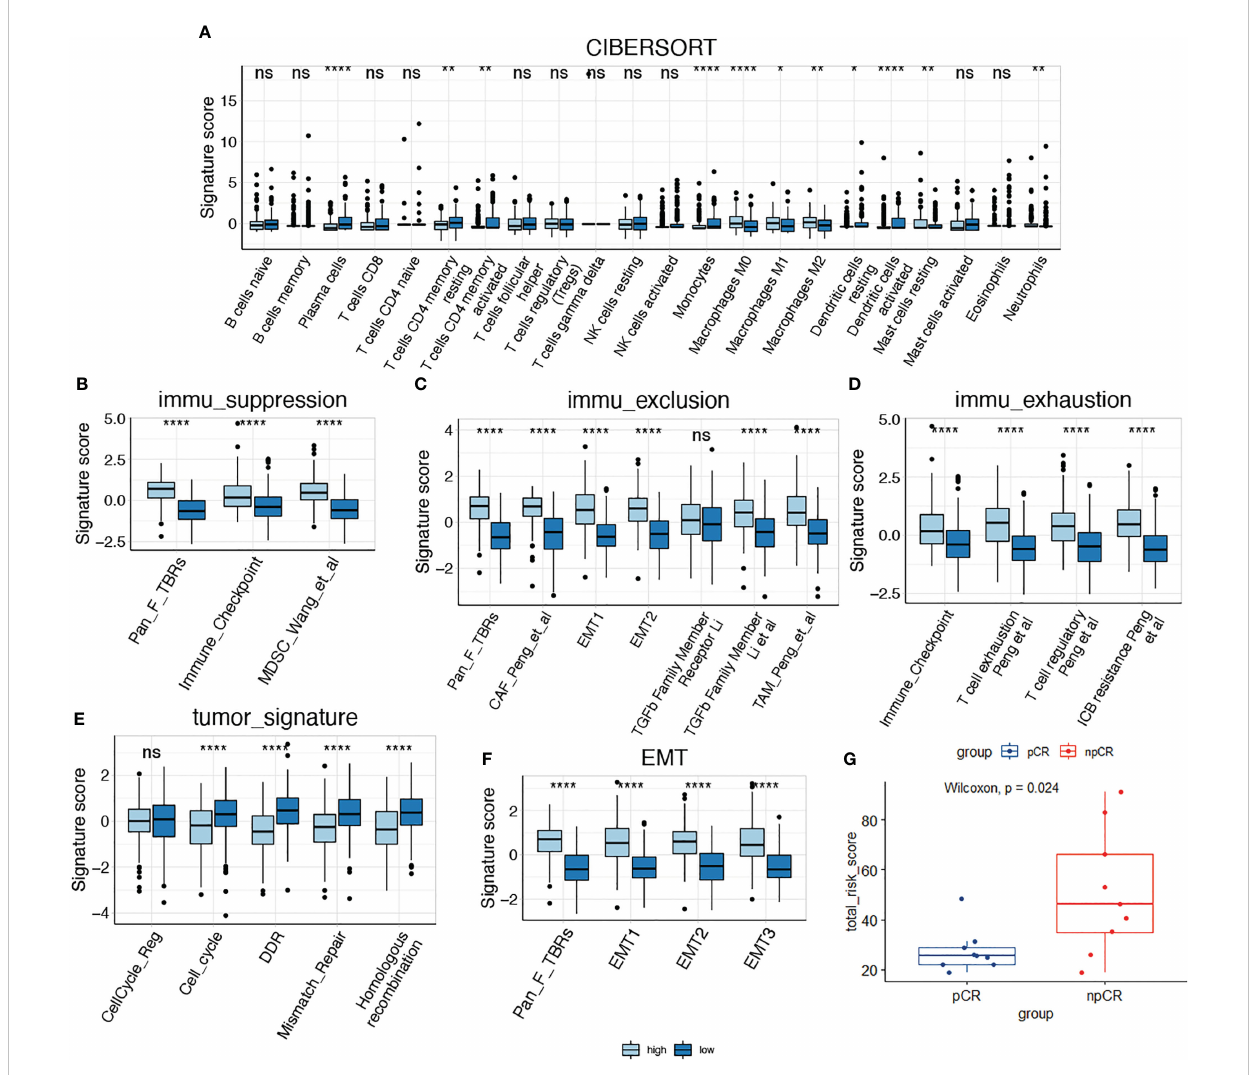
FIGURE 5 Comparison of tumor microenvironment features in high-risk and low-risk groups. (A) Comparison of the in fi ltration of immune cells between two subgroups; (B – D) Comparison of immune suppression, exclusion and exhaustion features between two subgroups; (E, F) Comparison of tumor signatures and EMT signatures between two subgroups; (G) Analysis of the senescence risk score in patients with different response to immunotherapy using a rectal cancer cohort (GSE213331). *P < 0.05; **P < 0.01; ****P < 0.0001; NS, not signi fi